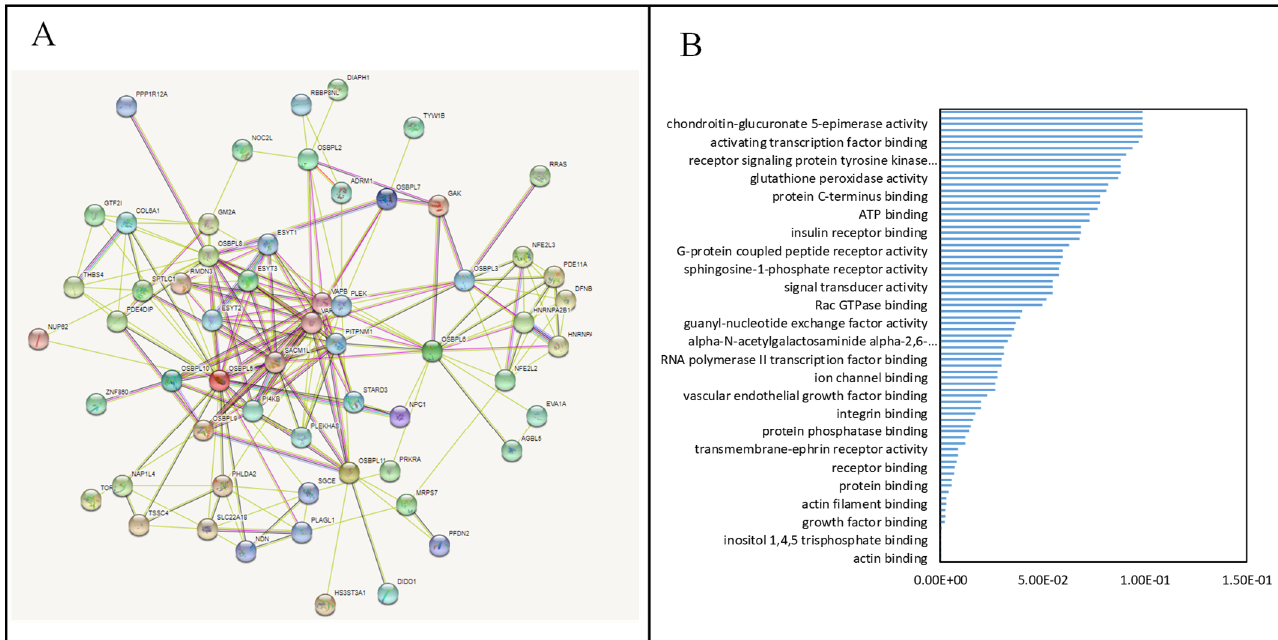
Figure 7. Protein–protein interaction (PPI) networks and pathways for the co-expression of oxysterol-binding protein (OSBP)-like (OSBPL) family members in pancreatic ductal adenocarcinoma (PDAC). ( A ) PPI networks of various proteins and OSBPL family members. Colors of the lines express the types of interactions by STRING. ( B ) Bar plot of gene ontology (GO) abundances in molecular function (MF)-enriched terms by cBioPortal and DAVID.